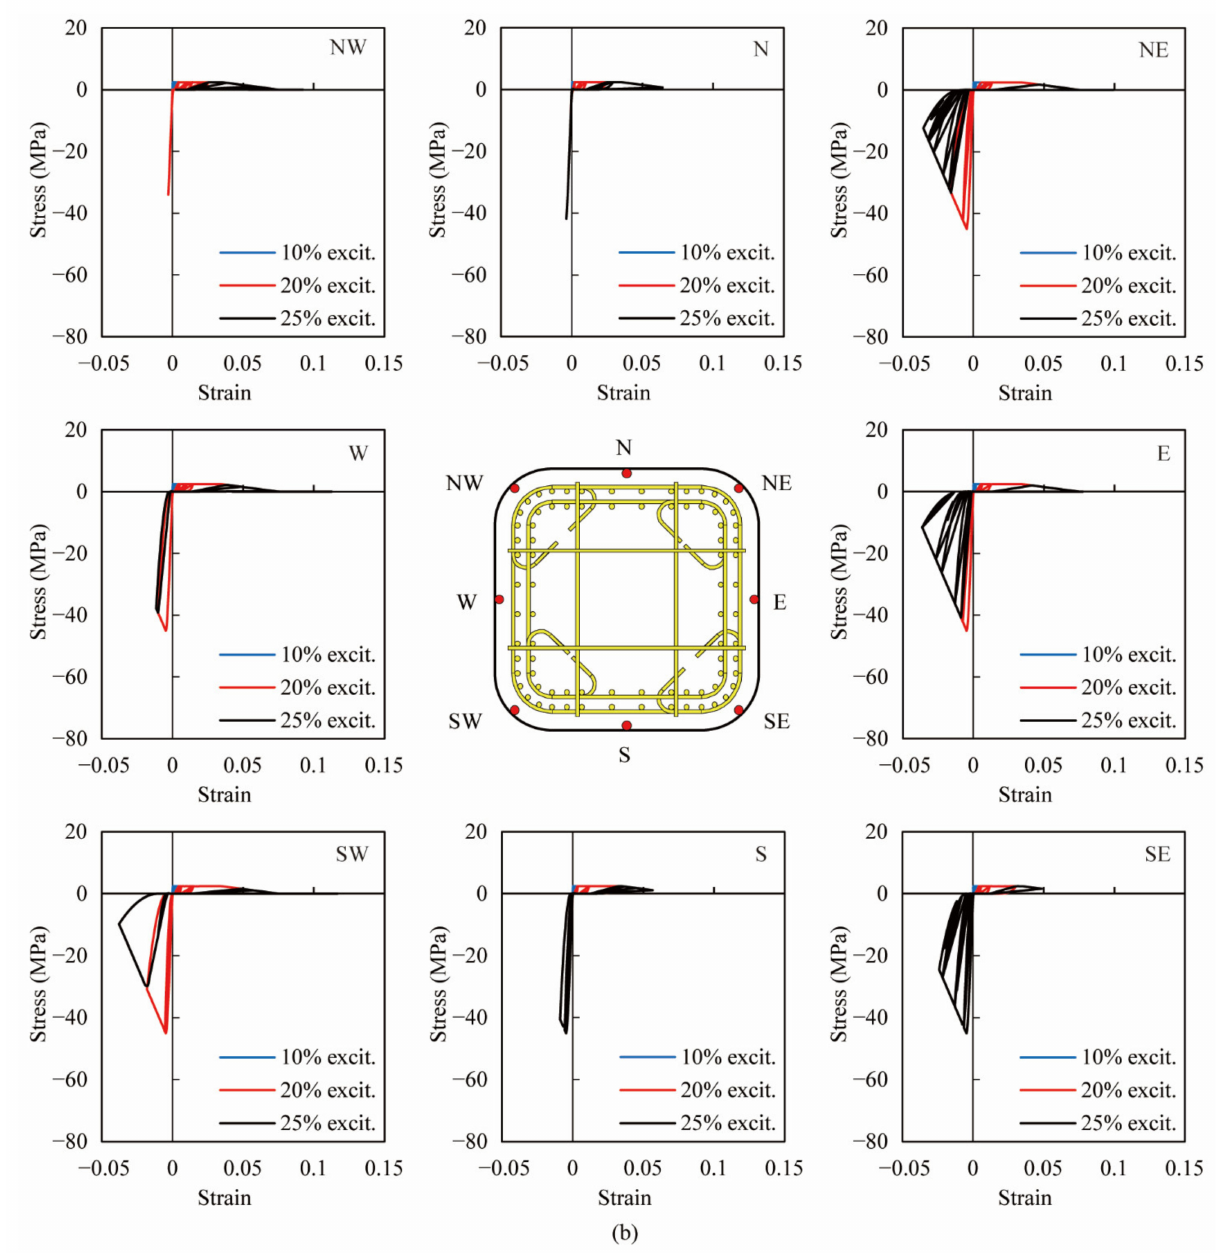
Figure 12. Analytical stress-strain hysteresis of extreme fibers in cover at the column base in eight directions. ( a ) PFRC-1, ( b )